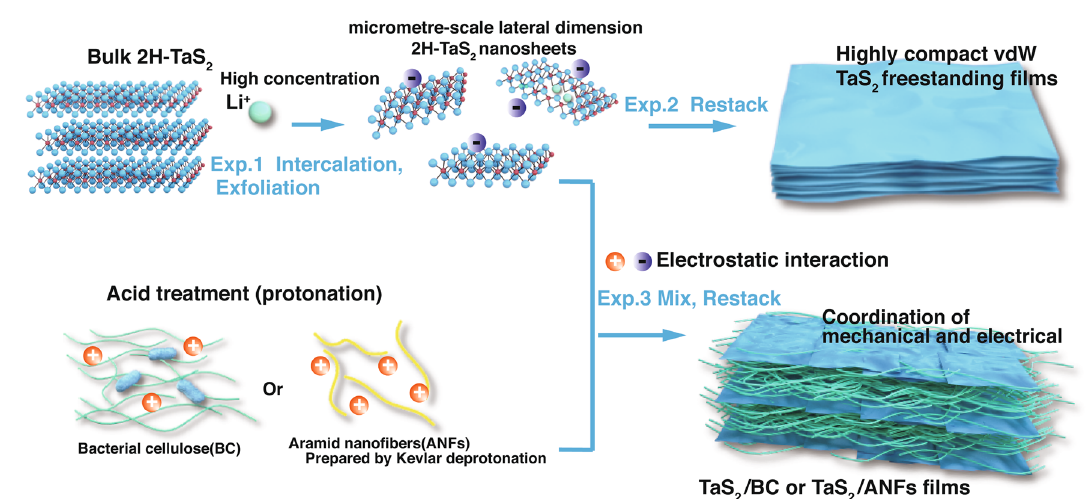
Fig. 1 Schematic illustrating the preparation processes of TaS 2 freestanding films, TaS 2 /bacterial cellulose (BC) or aramid nanofibers (ANFs) nanocomposite films